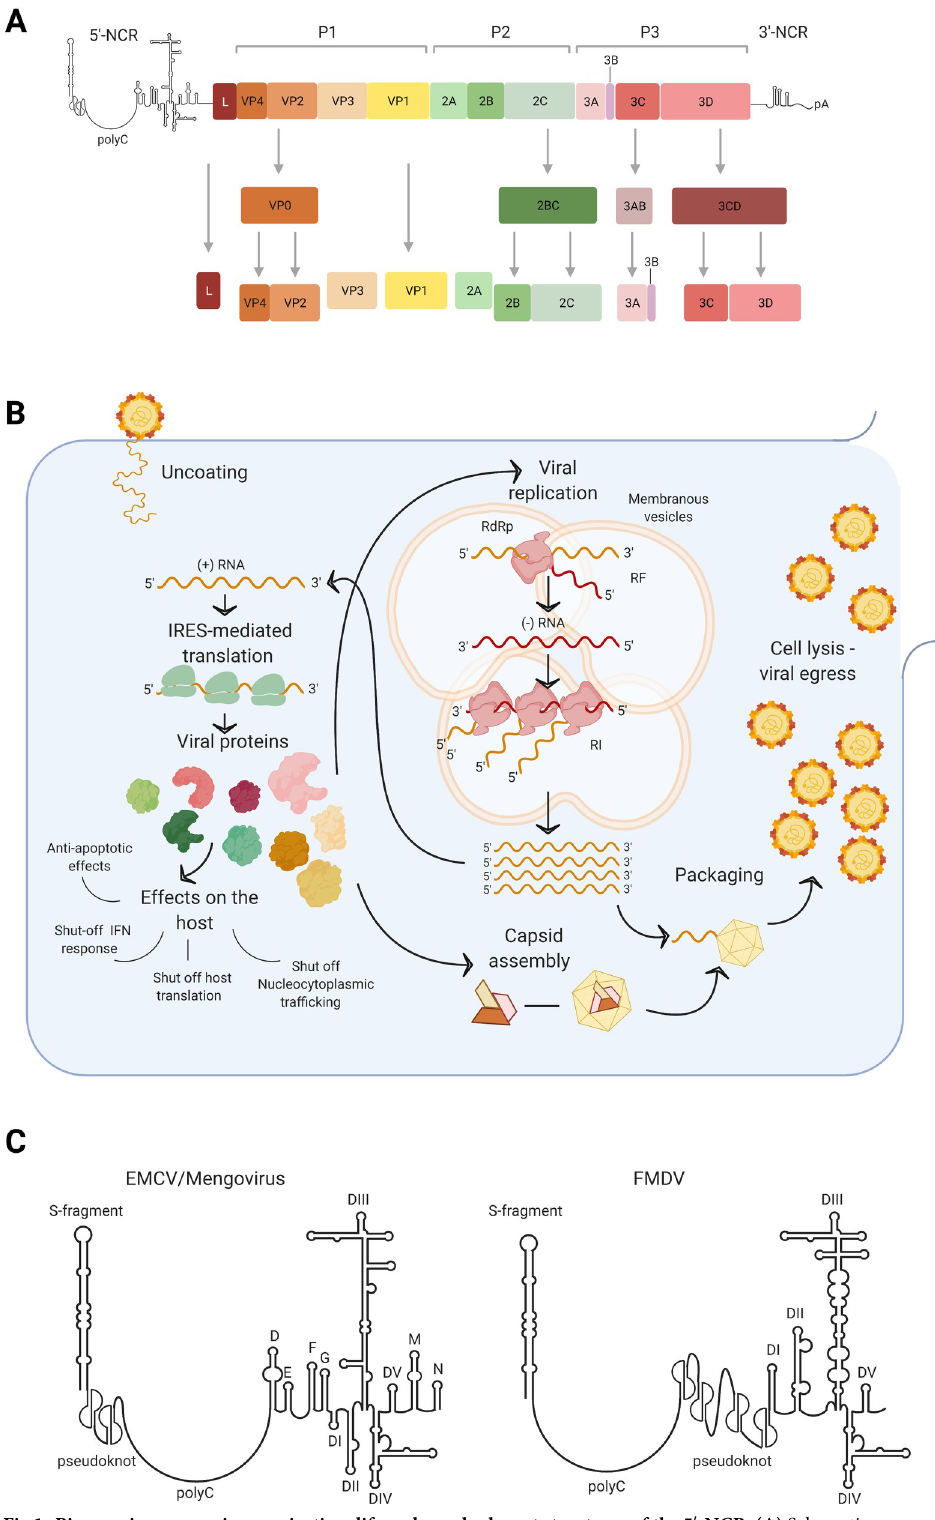
Fig 1. Picornavirus genomic organization, life cycle, and relevant structures of the 5 0 -NCR. (A) Schematic representation of picornavirus genome. Picornavirus positive single-strand RNA genome is composed of 2 NCRs in 5 0 and 3 0 flanking one open reading frame. The NCRs are highly structured and contain numerous functional RNA